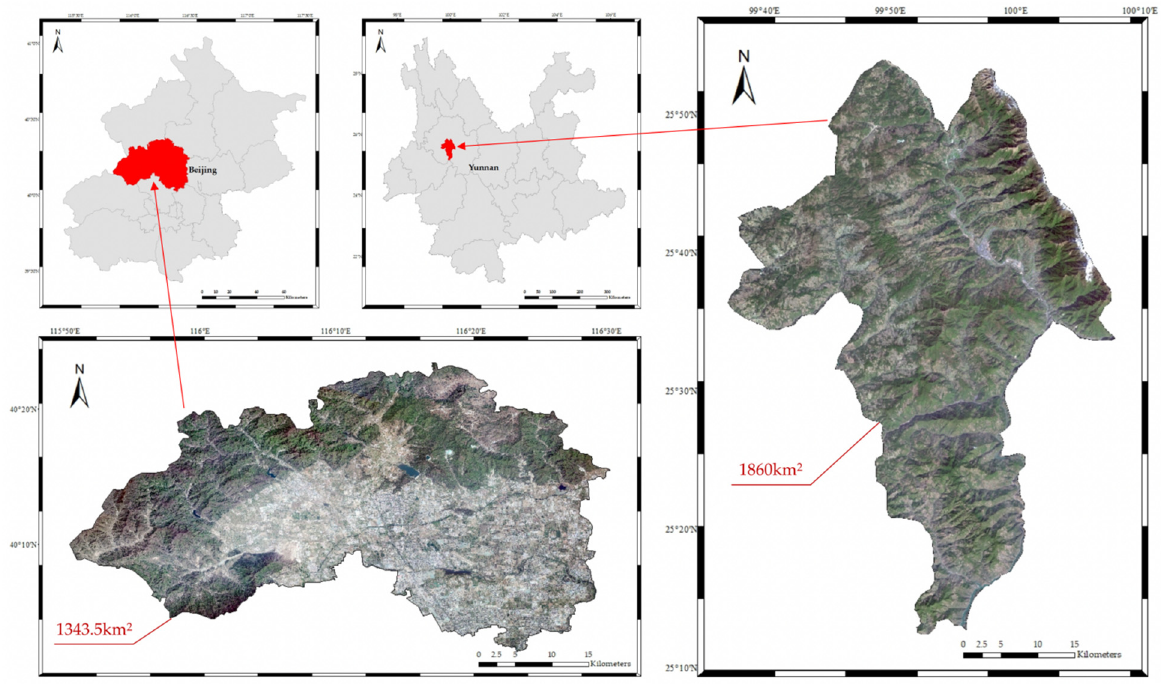
Figure 2. Study areas were Yangbi County in Yunnan Province and Changping District in Beijing, China.